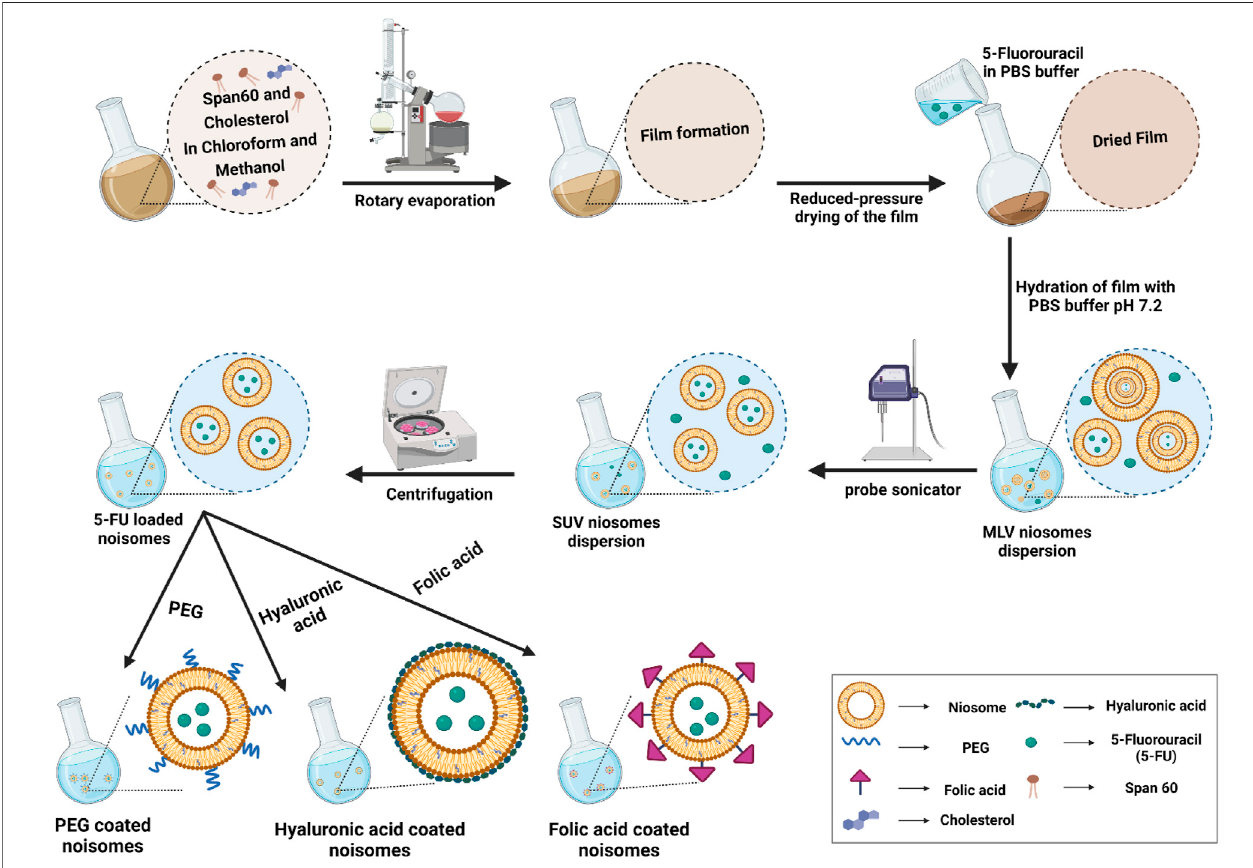
FIGURE1| Thepreparationandcharacterizationoffunctionalizedniosomesbythethinlayerhydrationmethod.MLV:multilamellarvesicles;SUV:smalluni-lamellar vesicles.